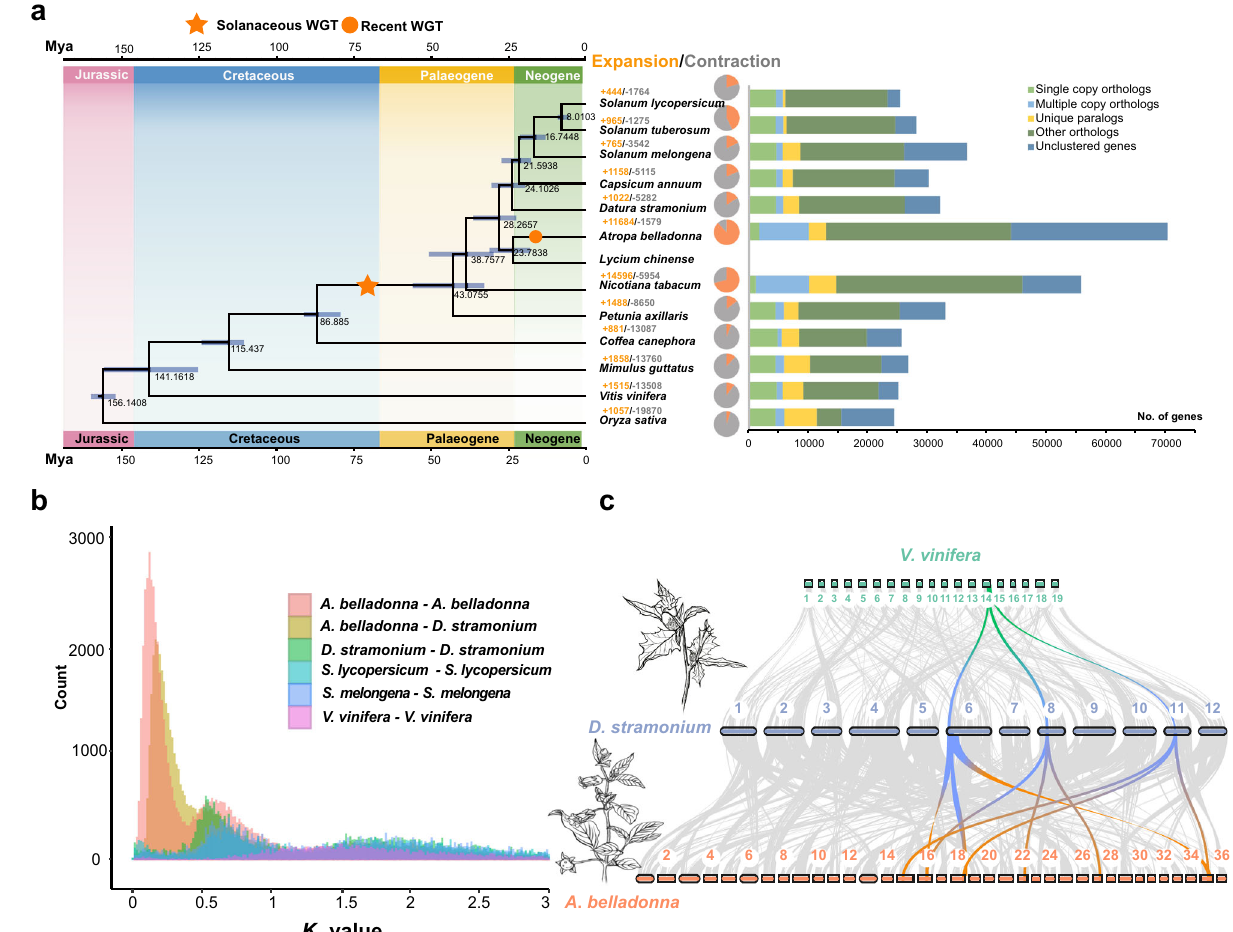
Fig. 2 | Phylogenetic relationships and divergence times among 13 species. a Phylogenetic tree of A. belladonna , D. stramonium , and L. chinense along with 10 other plants. Gene families of the A. belladonna , D. stramonium , and other sequenced genomesareshown onthe right. All branchbootstrap valuesare out of 100. Gene familyexpansions areindicatedin orange, and gene family contractions are indicated in gray; the corresponding proportions of total changes are shown using the same colors in the pie charts. The estimated divergence time (million yearsago,Mya)isindicatedateachnode;barsarethe95%highestposteriordensity